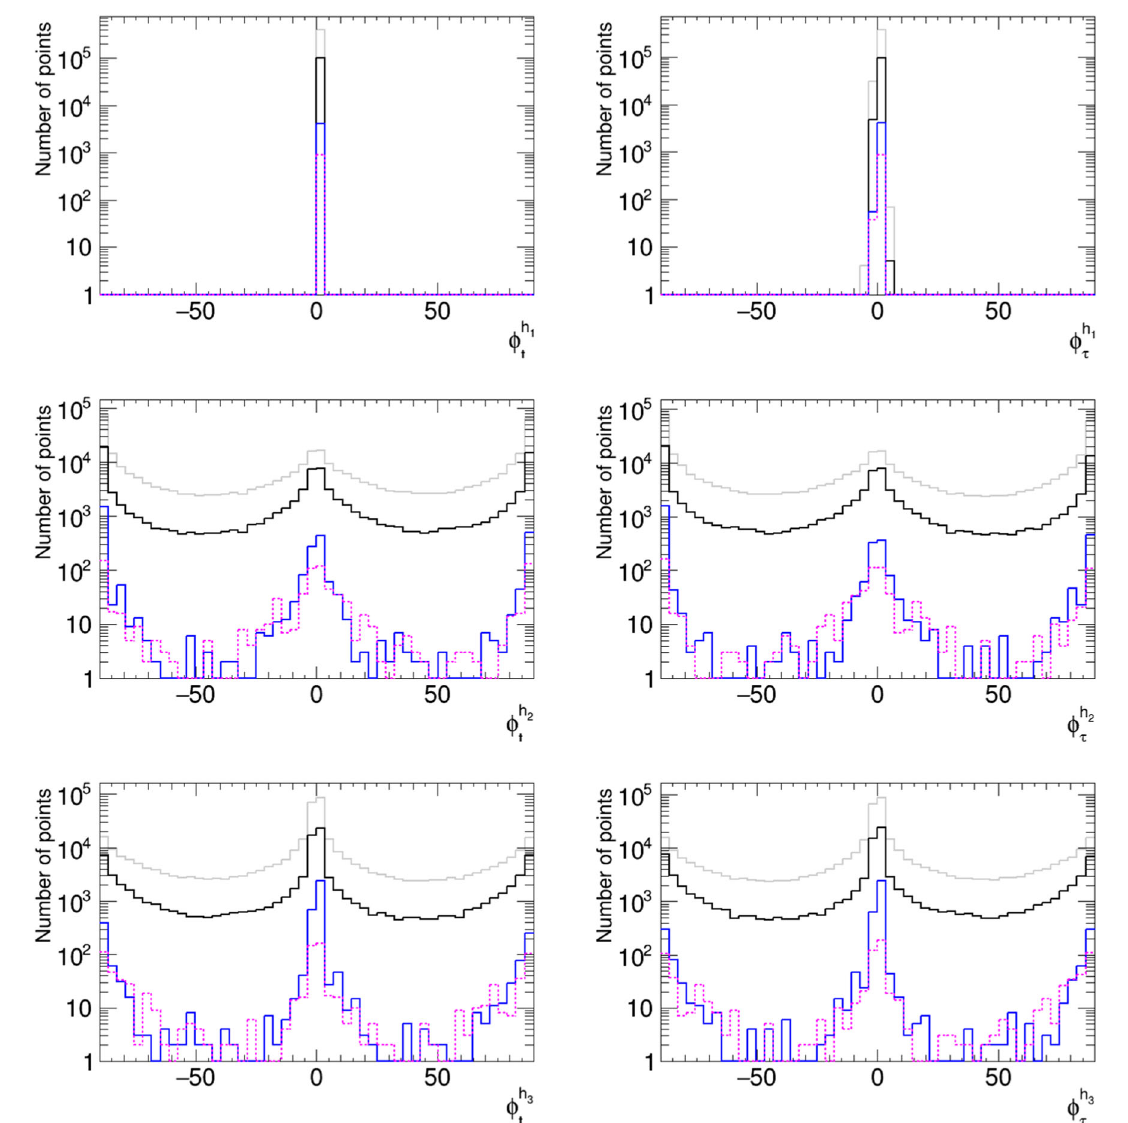
Fig. 12 Distributions of phases of third-generation fermion couplings to neutral Higgs bosons, showing the effects of taking into account the LHC constraints on sparticle masses and imposing the EDM con- straints. Left column, from top to bottom: top couplings to h 1 , 2 , 3 ; right: tau couplings to h 1 , 2 , 3 . Grey histograms: all points passing the LHC